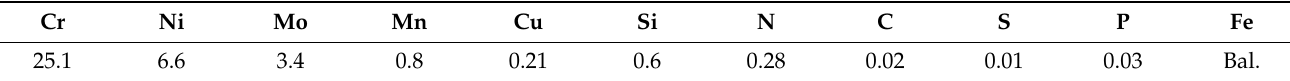
Table 1. Nominal compositions of SAF 2507 SDSS